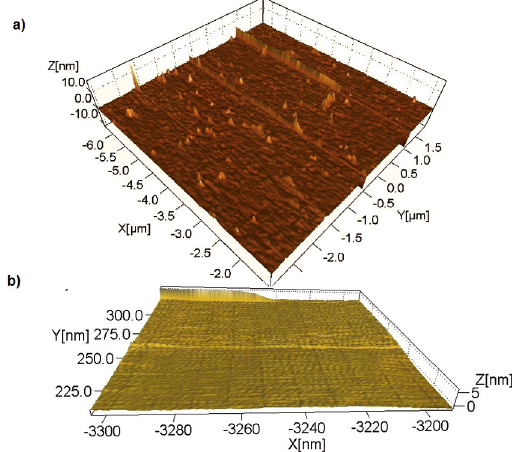
this emission spectrum, are as follow: The peak labelled as A observed at 8183 Å corresponds to a free exciton recombination, (F,X); The peaks B observed at 8186.7-8187.9 Å correspond to excited state bound to neutral donors, (D ° ,X) . The exc peak C at 8197 Å is associated to J=1/2 exciton bound to neutral acceptor, (A ° ,X) . The peaks labelled as D and E 1 = 2 correspond to conduction band to neutral acceptor at 8301 Å, (e-A ° ), and neutral donor to neutral acceptor at 8325 Å, (D ° -A°) transitions 4 , both of them associated with carbon as acceptor impurity. The existence of the free exciton peak at 8183 Å, labelled as A, is associated with the good crystalline quality of the GaAs epitaxial layers 5